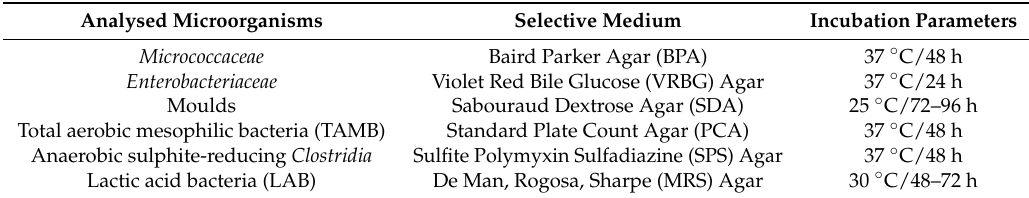
Table 2. Selective media and incubation